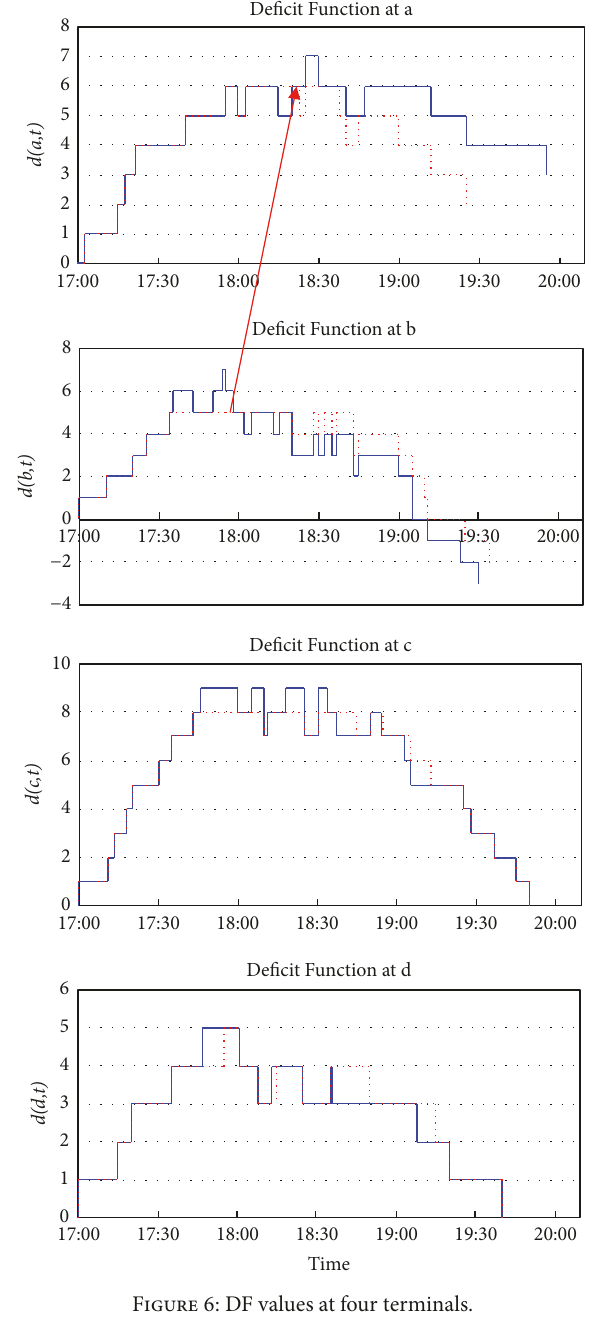
Figure 6: DF values at four